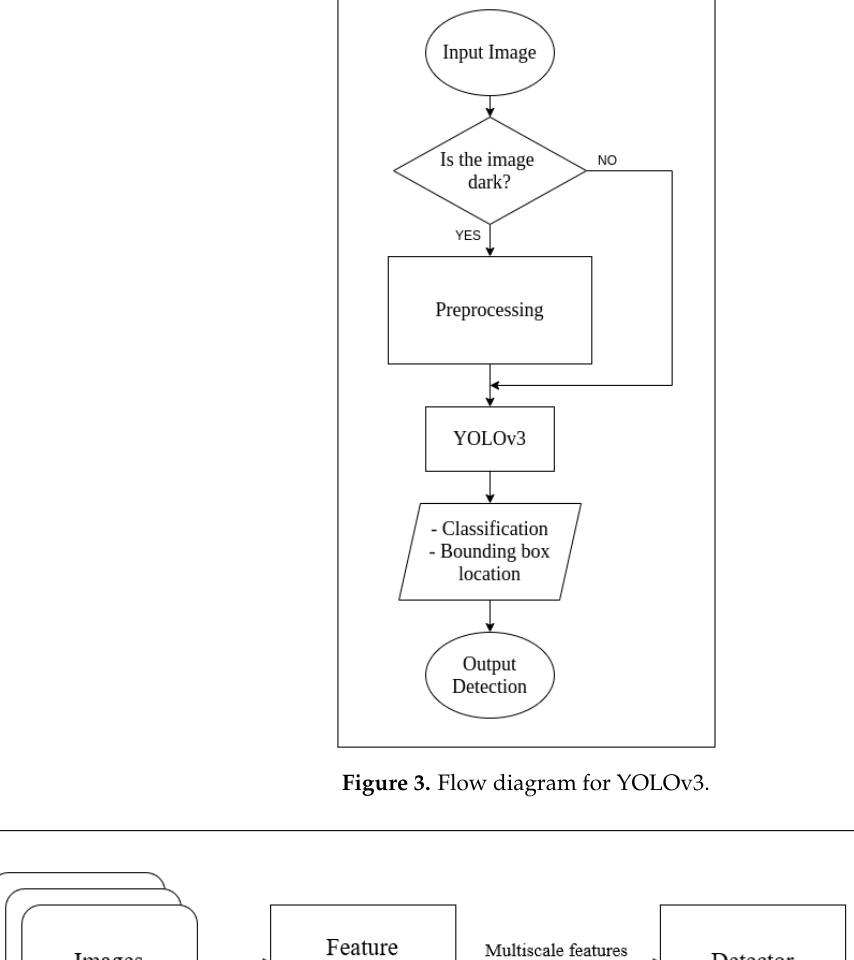
Figure 3. Flow diagram for YOLOv3.